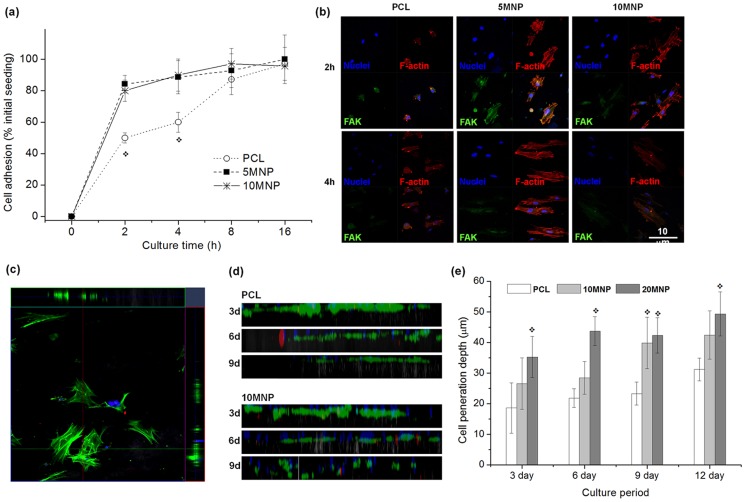
MC3T3-E1 cell adhesion and penetration tests on the nanofiber scaffolds.(a) Initial cell adhesion level on the nanofiber scaffolds during culture for up to 16 h, presented as % initial seeding. Significantly higher levels of cell adhesion noticed on the PCL-MNP scaffolds vs PCL (*p<0.05). (b) Cell adhesion morphology taken from confocal microscopy of immunofluorescent stained cells at 2 h and 4 h of culture; nuclei in blue, F-actin in red and FAK in green. (c–e) Cell penetration assay through the nanofiber scaffolds; exemplar image showing that z-stacking of immunofluorescence-stained cells (F-actin in green and nuclei in blue) were unfolded on xz- and yz-planes to reveal 2D constructed images (c), which were then combined to complete construction of depth profile of cells on 2D plane view (d, compared images of PCL and 10MNP samples at a culture period of 3, 6 or 9 days), and the quantification of depth profile (e, shown average positions of cell penetration depth), showing significant improvement in cell penetration within the nanofibers incorporating MNPs.